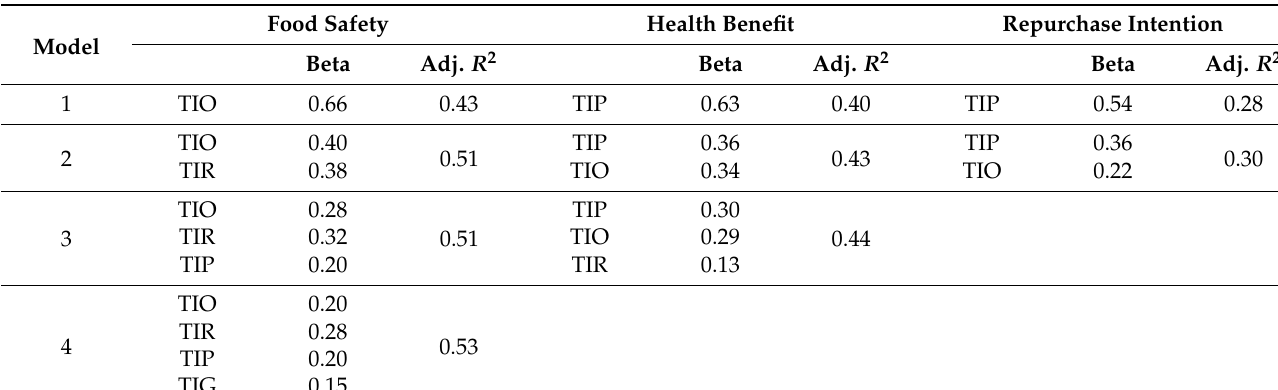
Table 4. Results of stepwise